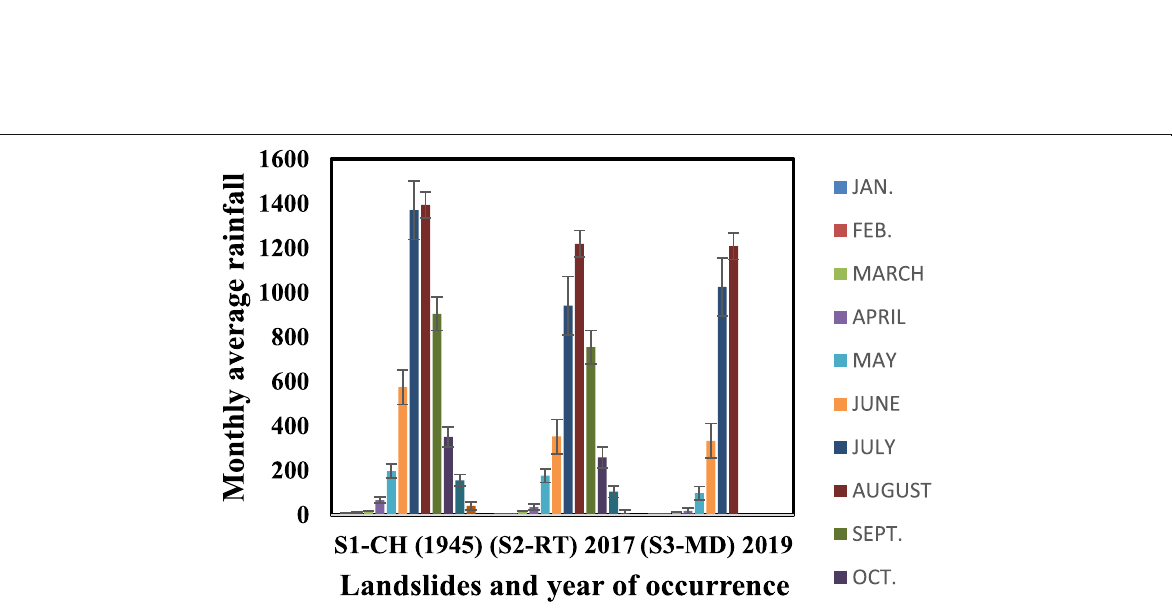
Fig. 2 Monthly average rainfall for the years the studied landslides occurred